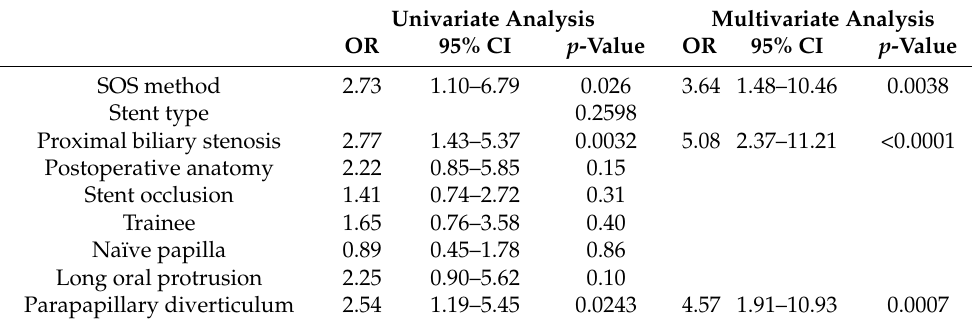
Table 5. Univariate and multivariate analyses of predictors for unsuccessful PS replacement. Univariate